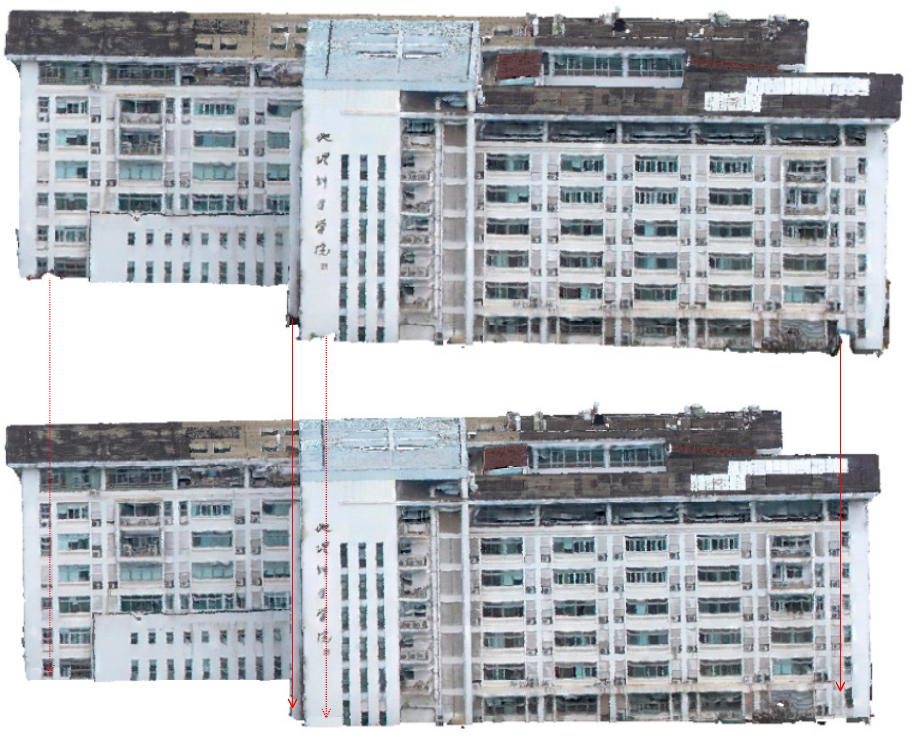
Figure 9. Filled results of front holes (red lines represent the corresponding areas).